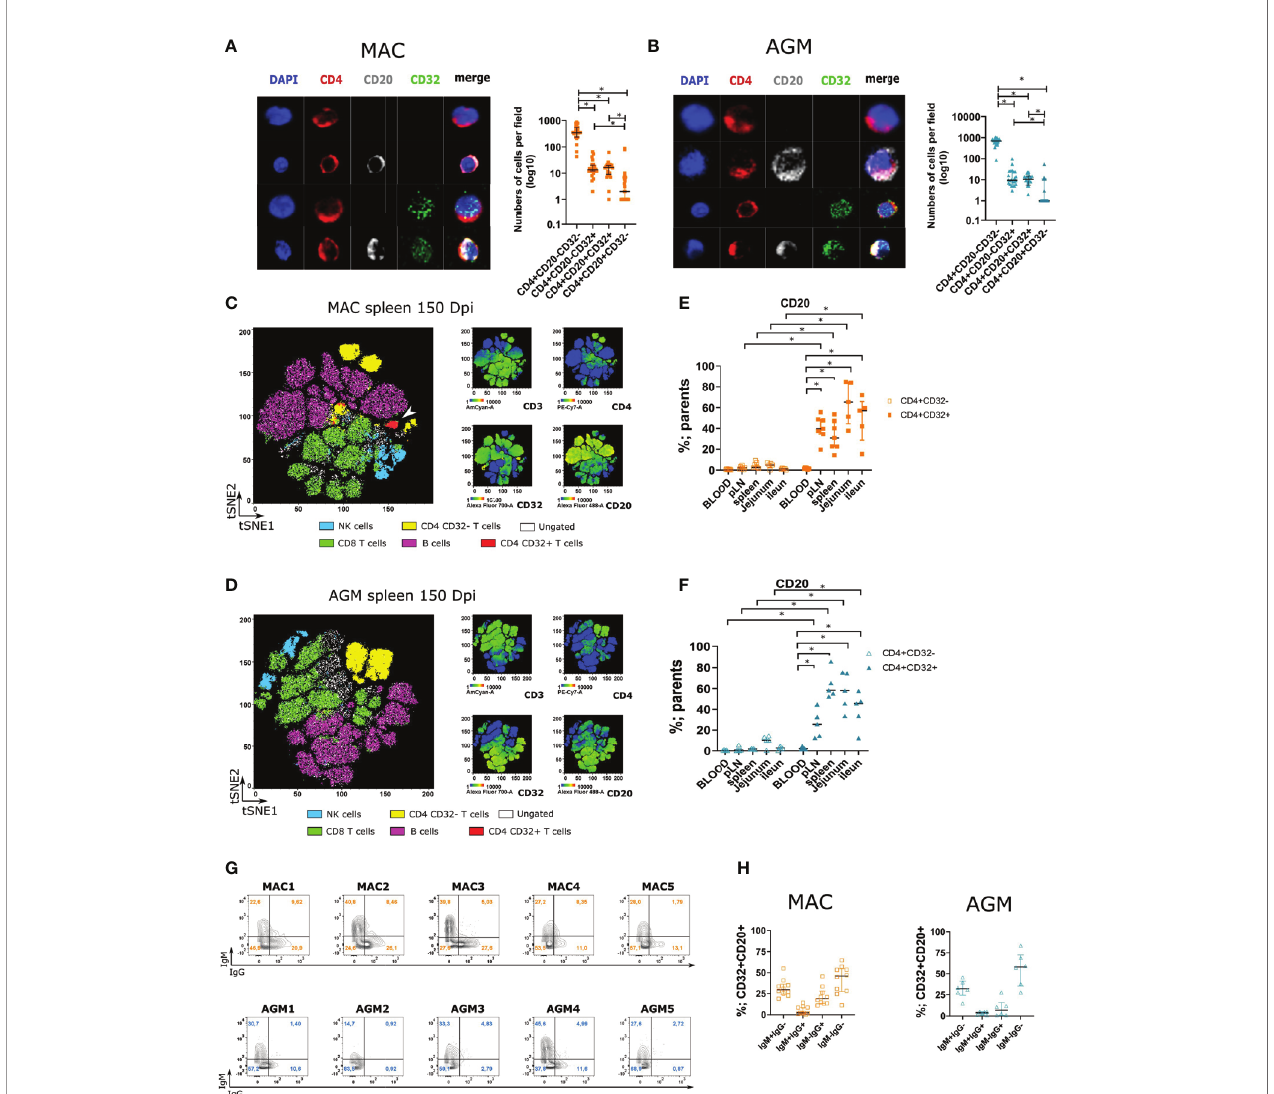
FIGURE 5 | Analyses of CD32+CD4+CD3+ cells expressing CD20 in the spleen of SIV-infected animals. (A, B) Confocal images of CD4+ T cells according to CD4, CD20, and CD32 staining. Staining was performed on CD4+CD3+ cells isolated from chronically SIV-infected MAC (A) and AGM (B) . Graphs with cell numbers per fi eld are shown on the right. The experiment was performed with samples from three monkeys per species and eight fi elds were counted per monkey. (C, D) viSNE map representing concatenated spleen cells from 6 MAC (D) and 6 AGM (C) . Cells were stained with 9 markers and measured by fl ow cytometry. viSNE analysis was performed on 60000 live CD45 + single cells per sample using all 8 surface markers. viSNE map shows concatenated fl ow cytometry standard fi les for all (C) MAC and (D) AGM samples. Overlay of 6 manually gated cell populations on viSNE plots, de fi ned as: CD8+T cells (live, CD45+CD3+CD8+), NK cells (live, CD45+ CD3-NKG2a+), B cells (live, CD45+CD3-CD20+), CD32+CD4+ T cells (live, CD45+CD3+CD4+ CD32+), CD32-CD4+ T cells (live, CD45+CD3+CD4+CD32-). Intensity of CD3, CD32, CD4, CD20, is shown for all samples, overlaid on the viSNE map. White arrows indicate CD32+CD4+ T cells. Cells not identi fi ed by such biaxial gating within CD45 + cells in the viSNE plots are shown in white. (E, F) Percentage of CD20+ cells within CD32+ CD4+ and CD32 - CD4+ cells from distinct tissues of chronically infected (E) MAC and (F) AGM. (G) Frequency of IgM and IgG on CD4+CD20+CD32+ T cells in the spleen of chronically infected MAC (upper part) and AGM (lower part). (H) Distribution of CD32+CD20+CD4+ T cells according to their expression of IgM and IgG in MAC (orange) and AGM (blue). In Figures 4A, B , a Friedman test was applied. In Figures 4C, D , statistical differences were assessed by ANOVA with Tukey adjustment for multiple comparisons. Asterisks indicate p-values <